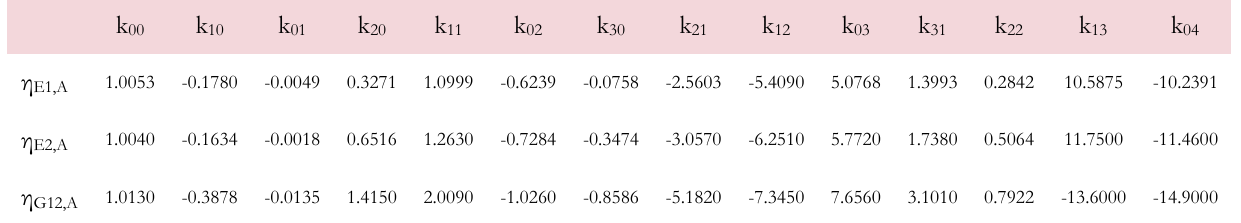
Table 1: polynomial coefficients (kij) for the values of  E1,A ,  E2,A and  G12,A